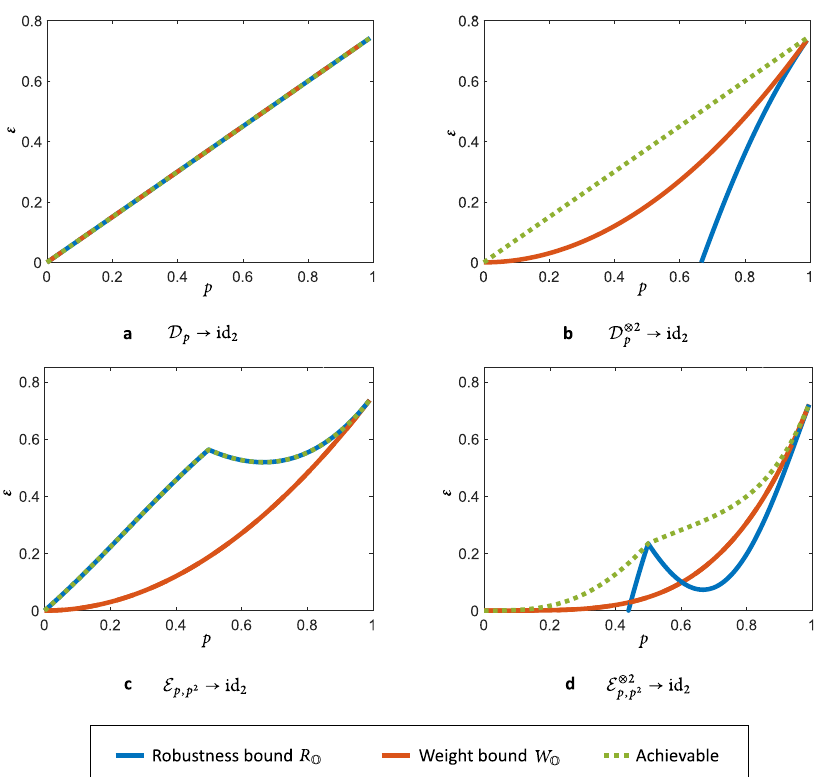
Fig. 4 Errors in one-shot quantum communication. Lower bounds on the error ε in the transformation of channels to the qubit identity channel id 2 under . We plot the bounds obtained from Theorem 1 for: a , b the qubit depolarising channel D p ð ρ Þ ¼ ð 1 (cid:3) p Þ ρ þ p 1 d ; ( c , d ) the dephrasure no-signalling codes S NS channel E p ; q ð ρ Þ ¼ ð 1 (cid:3) q Þ½ð 1 (cid:3) p Þ ρ þ pZ ρ Z (cid:6)þ q 2 j i 2 h j 86 , where we set q = p 2 . In ( a ) the depolarising channel satis fi es W O ð D p Þ ¼ p , and the robustness and weight-based bounds are actually equal: we have ε ≥ p ( d 2 − 1)/ d 2 . In fact, here the bounds match the achievable fi delity, meaning that Theorem 1 quanti fi es the error in the one-shot transformation D p ! id 2 under S NS exactly. The robustness bound is also seen to be tight in ( c ). The weight bound can become more effective than the robustness bound when we consider more copies of the input channel, as seen in ( b ) and ( d ). The importance of the weight bound is highlighted here, as it can certify that zero-error ( ε = 0) communication is impossible for all p >